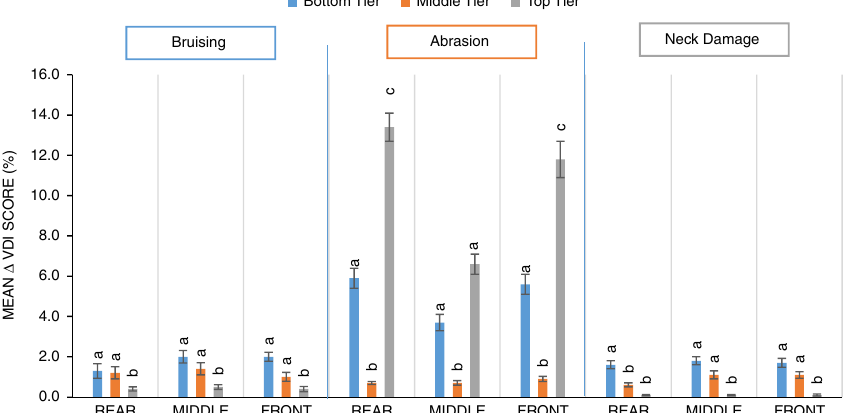
Figure 4. Δ VDI scores in different package- storage positions in the truck during the interstate